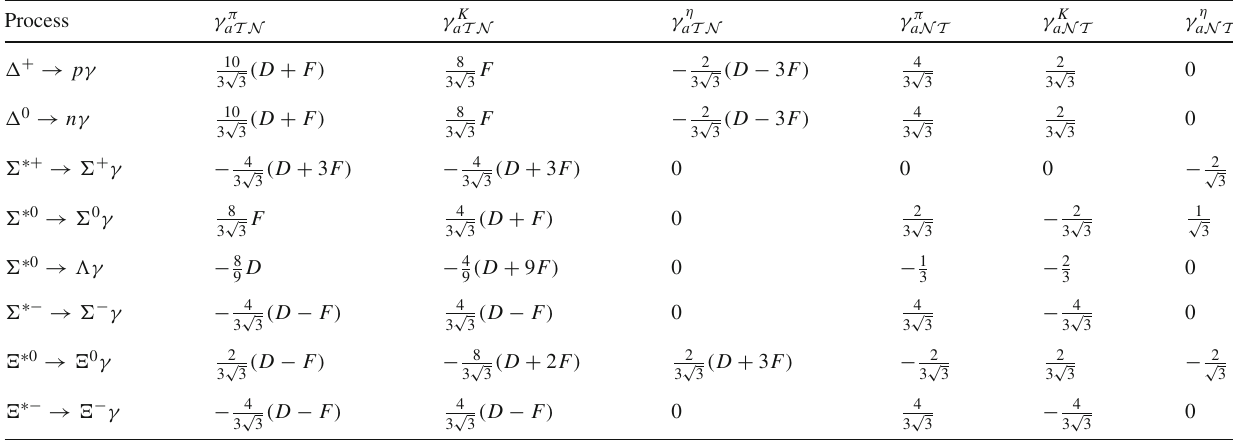
Table 10 The coefficients of the loop corrections to the decuplet to octet baryon transition magnetic moments from Figs. 2(g) and 2(h) Process